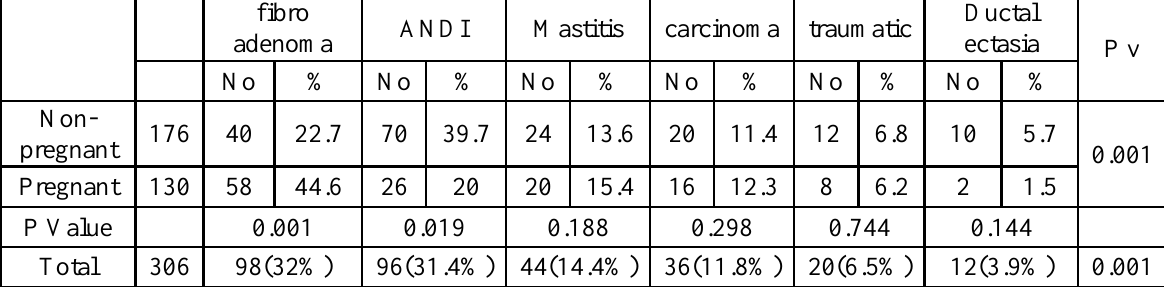
Table 2: Associations between studied groups and type of